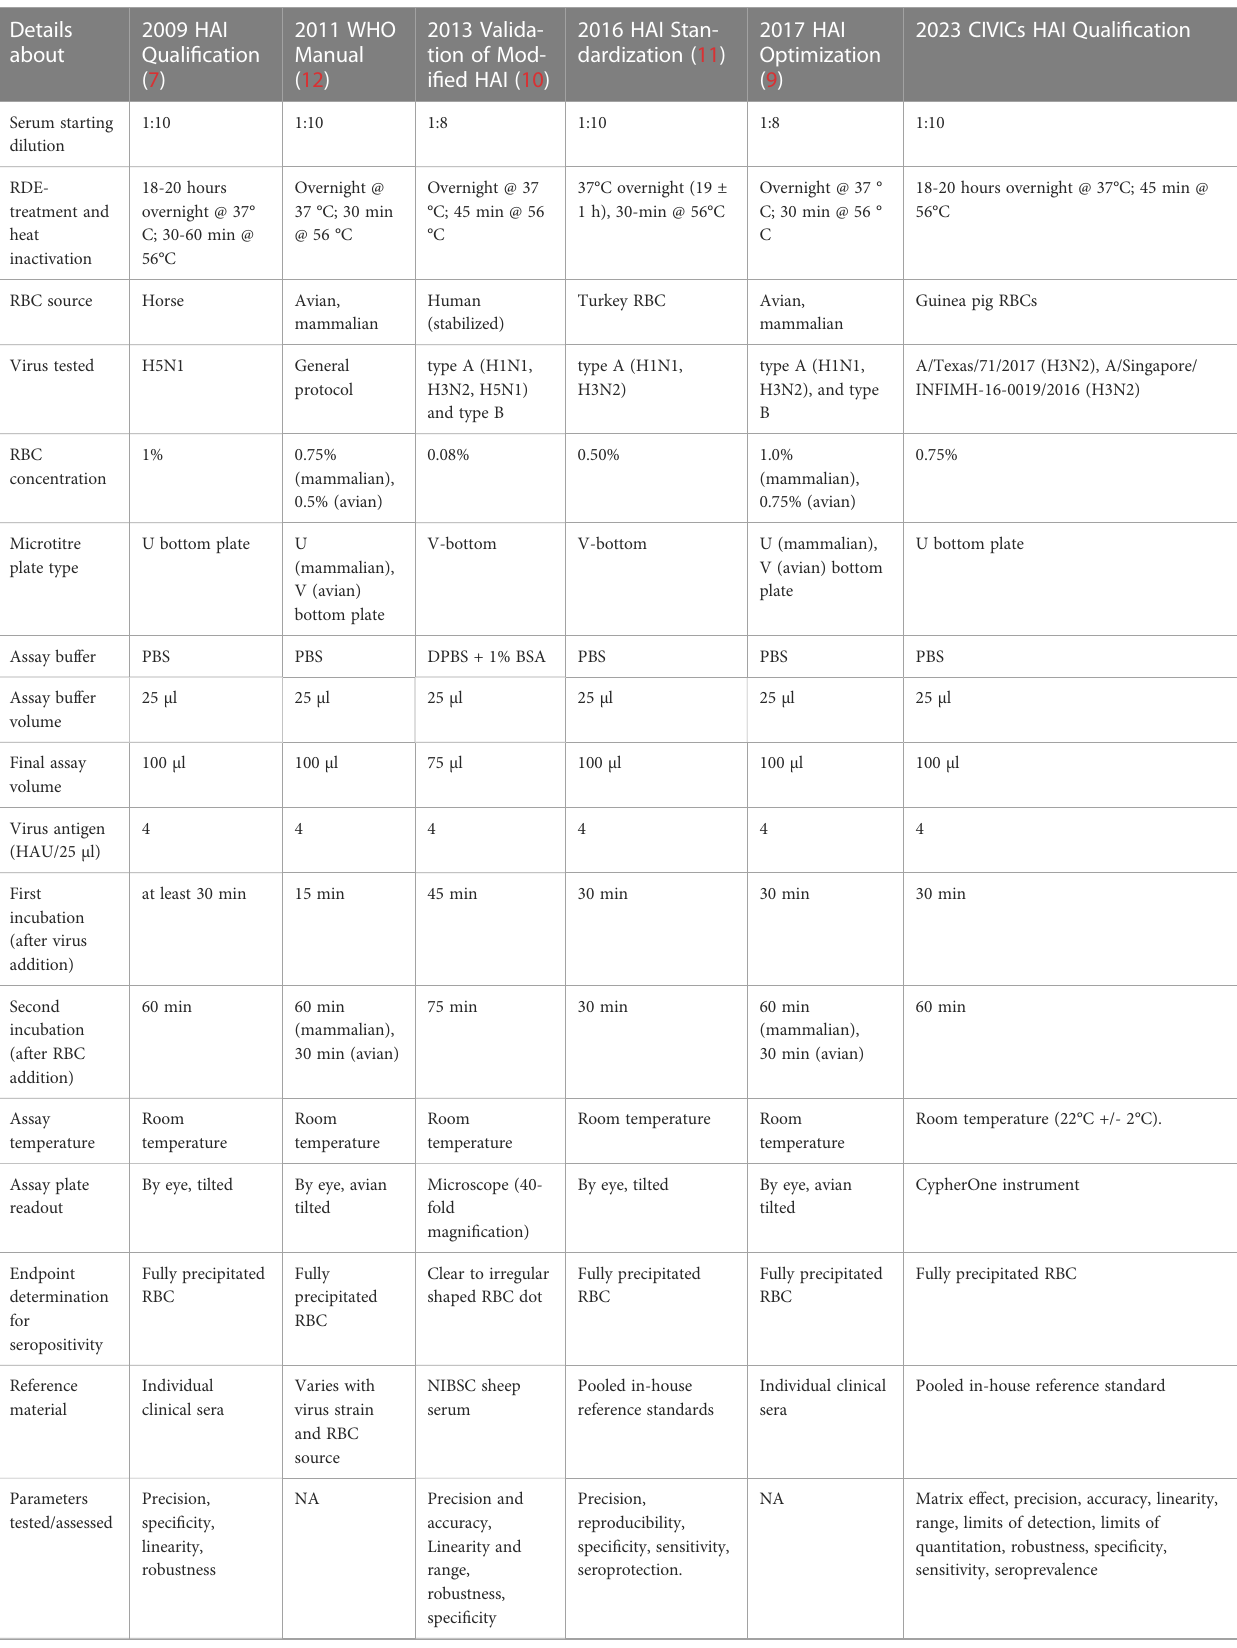
TABLE 1 Table comparing the previous literature on HAI assay development efforts in terms of assay design, data processing and statistical analysis